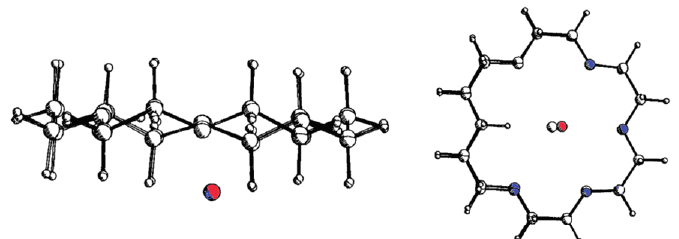
Figure 1. Complexation of potassium ions with crown ethers 18C6 and 18C5; superimposed structures of the K + -complexes (the K + -ion in the 18C5 complex in red); with binding free energies Δ G in kJ/mol, and differences ΔΔ G between them [7]. Adapted with permission from Raevsky, O.A.; Solovev, V.P.; Solotnov, A.F.; Schneider, H.-J.; Rüdiger, V. Conformation of 18-crown-5 and its influence on complexation with alkali and ammonium cations: Why 18-crown-5 binds more than 1000 times weaker than 18C6.